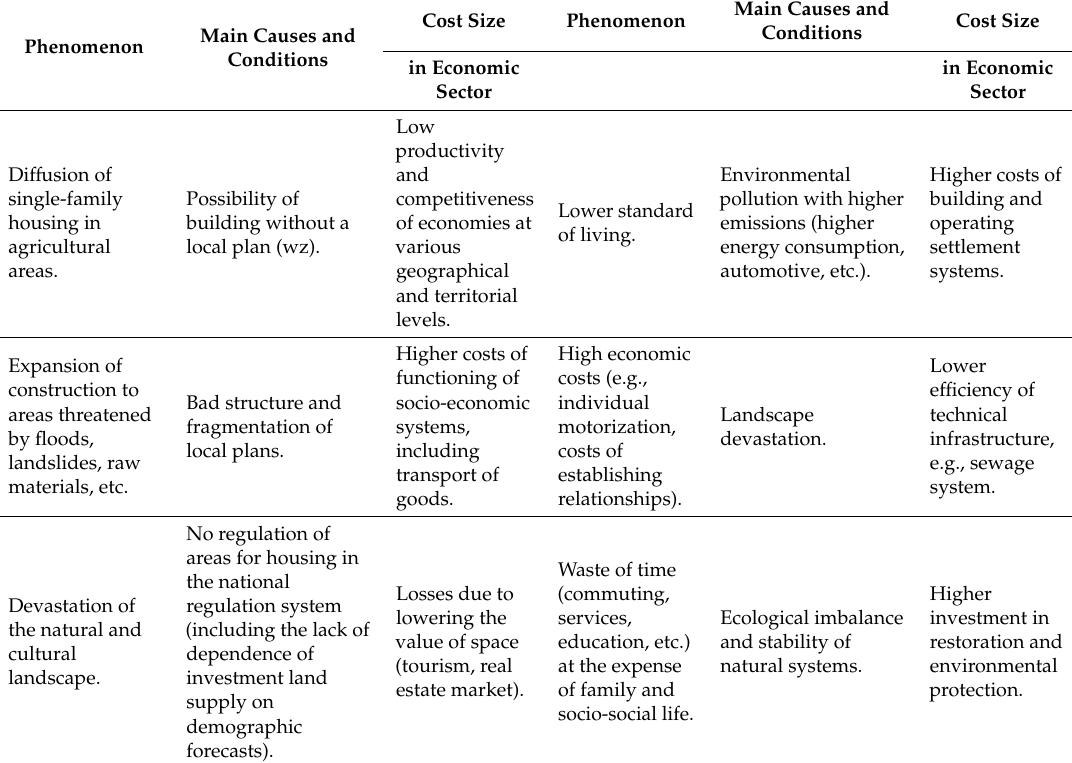
Table 1. General identification of phenomena, conditions, causes and related costs of spatial chaos. Main Causes and Phenomenon